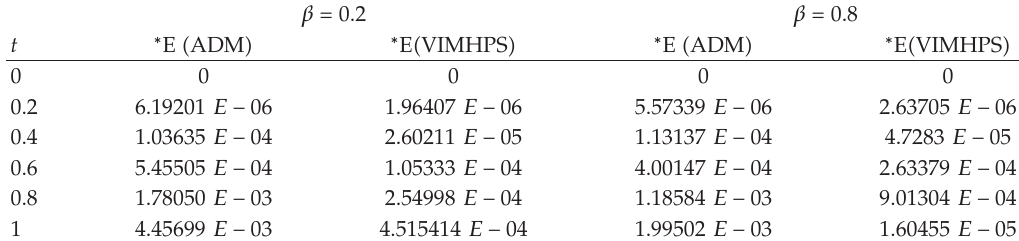
Table 7: Numerical results for Fisher’s